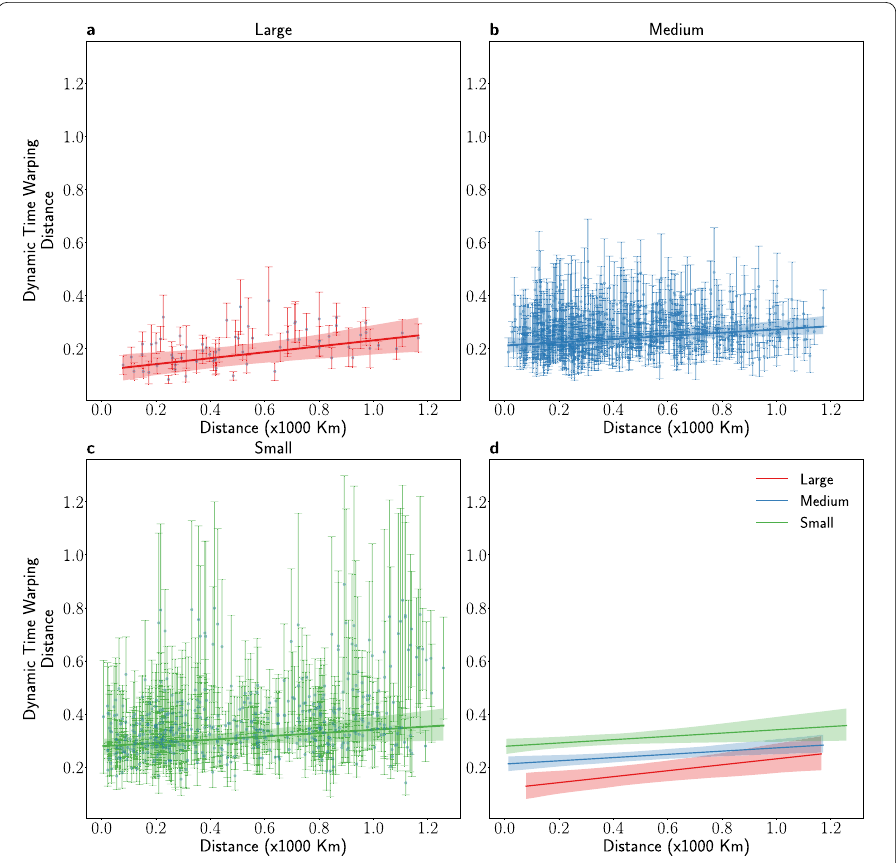
Figure 4 Bootstrap for weekends. ( a ) shows the results of the bootstrap for couples of Large cities during the weekends. The point and the bars represent the mean and the standard deviation obtained for each couple using the jackknife sampling method. The shaded area represents the 95% confidence interval obtained using the bootstrap method described in Materialsandmethods and the line represents the bootstrapped Weighted Least-Square Regression (WLS) fit. ( b ) as ( a ) but for the Medium cities. ( c ) as ( a ) but for Small cities. ( d ) summarizes the estimates of the bootstrap regression previously obtained in figures ( a )–( c ). Note that error bars and confidence intervals are larger, due to less data availability for weekends (our dataset consists of 6 weekend days and 18 weekdays)